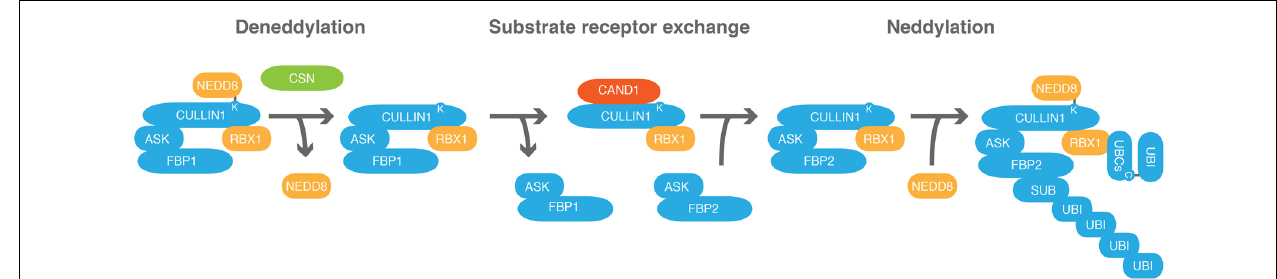
RBX1 and FBP form an SCF-type CRL. COP9 SIGNALOSOME (CSN) promotes CULLIN deneddylation. CULLIN-ASSOCIATED-NEDD8- DISSOCIATED1 (CAND1) is an exchange factor that can only associate with deneddylated cullins and promotes substrate receptor exchange. C, cysteine; K,